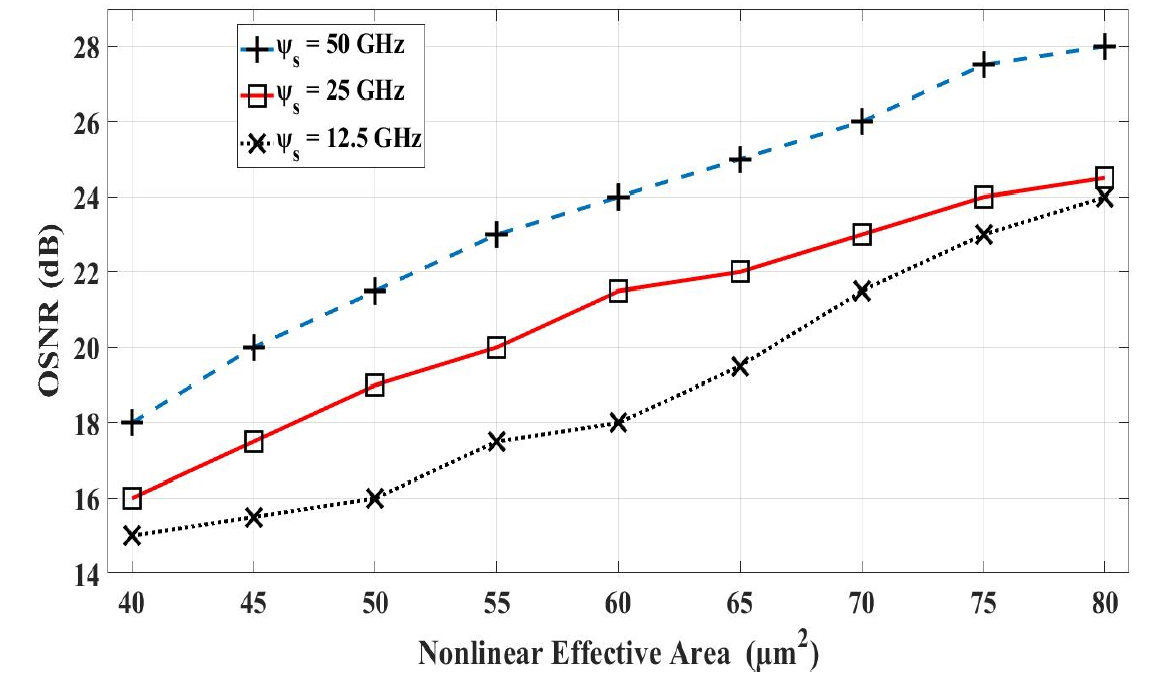
Figure 8. OSNR versus nonlinear effective area for 32 number of channels, 100 Gbps aggregate data rate, considering different channel spacing values.